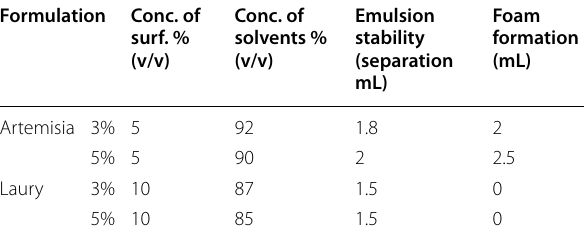
Table 2 Emulsion stability and foam formation of EC laboratory‑ prepared formulations Formulation Conc. of surf. %